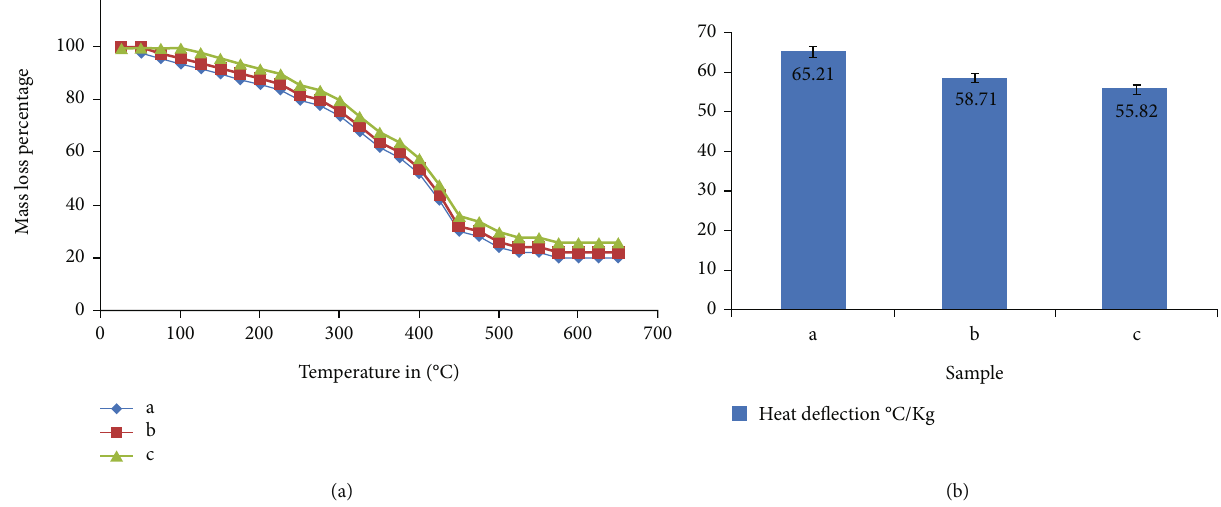
Figure 3: (a) Thermal adsorption behaviour on mass loss of epoxy hybrid composites. (b) Heat de fl ection temperature of epoxy hybrid